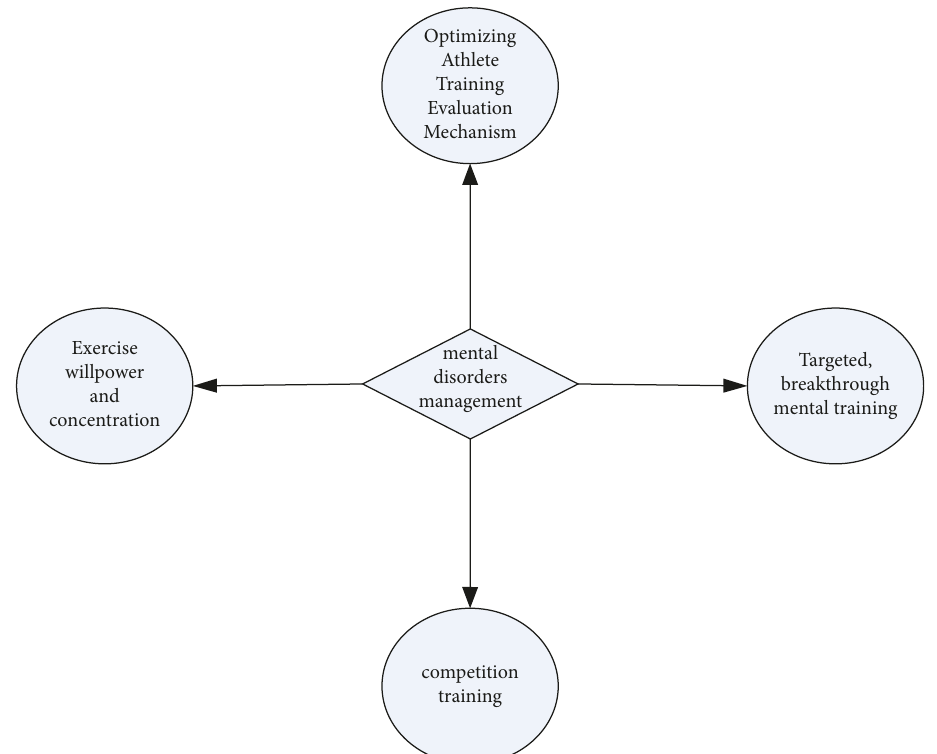
Figure 5: Methods of regulating mental